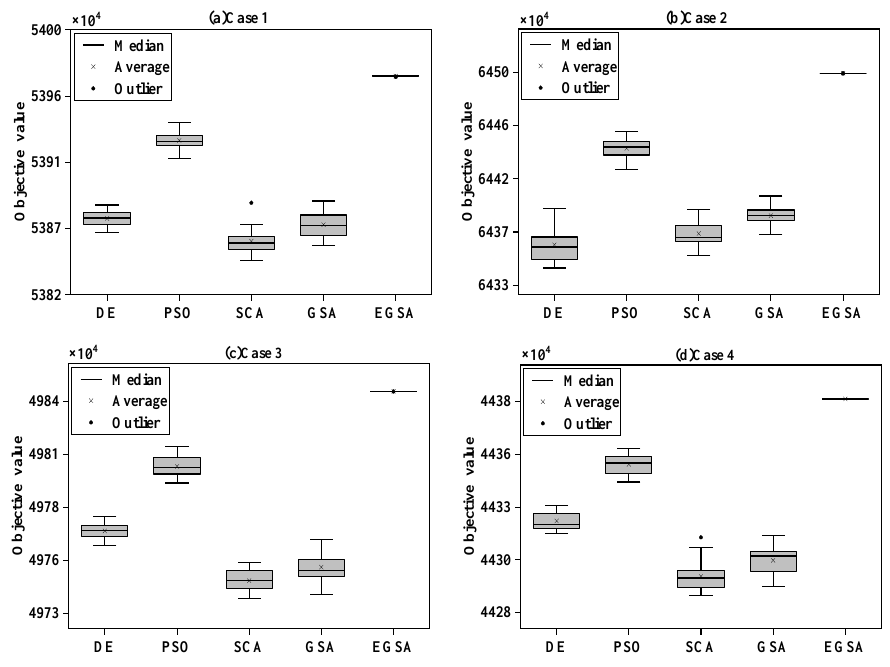
Figure 7. Box and whisker test of di ff erent algorithms in di ff erent cases for power generation.